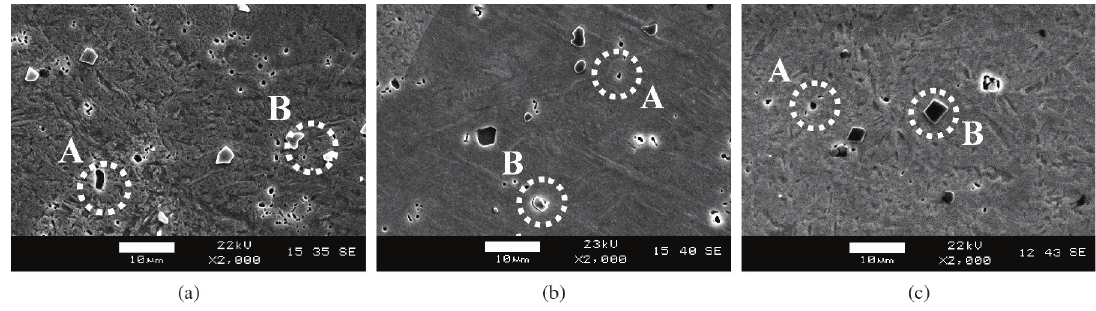
Figure 3. SEM backscattered electron images (ND-TD) of Ti55Ni alloy deformed by 1 ECAE pass and annealed at (a) 300 °C/1h, (b) 400 °C/1h and (c) 500 °C/1h. (SEM-SE).